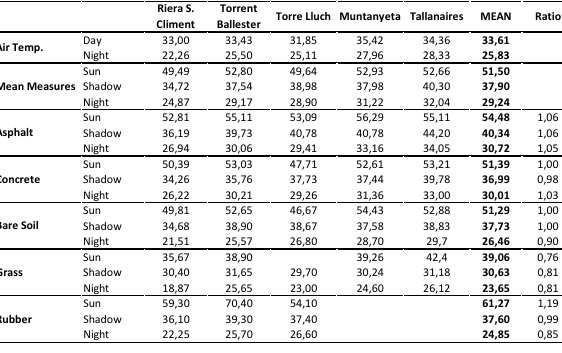
Table 6. LST of different materials in public space The study was carried out in a heat wave episode, with an average air temperature of 33.61 degrees during daytime and 25.83 at night field measurements. As can be seen in the table, asphalt and concrete maintain high radiant temperatures during the night, 5% and 3% higher than the average of all measurements. The bare soil, hot during the hours of sunlight (ratio = 1), cooled significantly during the night (ratio = 0.90). Vegetated soil (grass) is always cooler than the average of field measurements: between 24% during the day (on surfaces exposed to the sun) and 19% at night. And rubber, very hot during the day (ratio = 1.19), gets very cold at night (ratio =